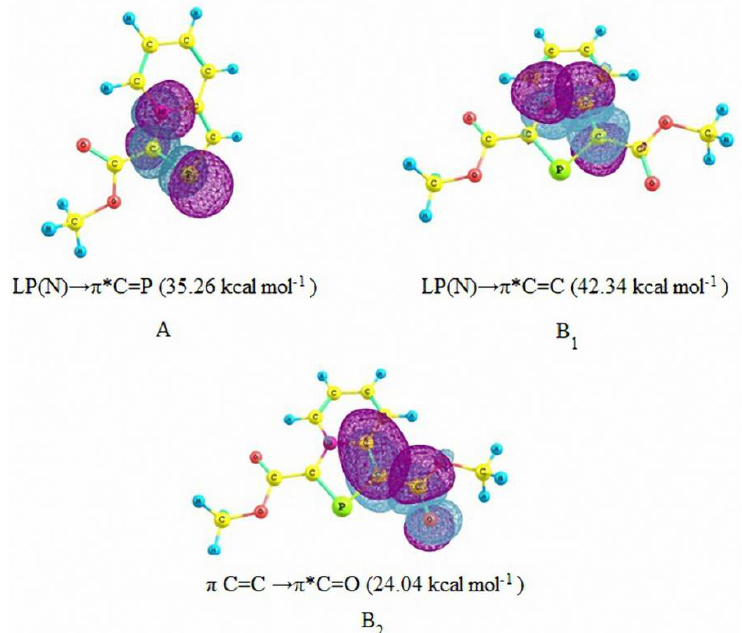
Figure 3. Natural Bond Orbital (NBO) interactions in 3-methoxycarbonyl-1,3-azaphospholo[5,1- a ]pyridine ( A ) and 1,3-bis(methoxycarbonyl)- 1,3-azaphospholo[5,1- a ]pyridine ( B 1 and B 2 ) with second order perturbation energies (in parenthesis).